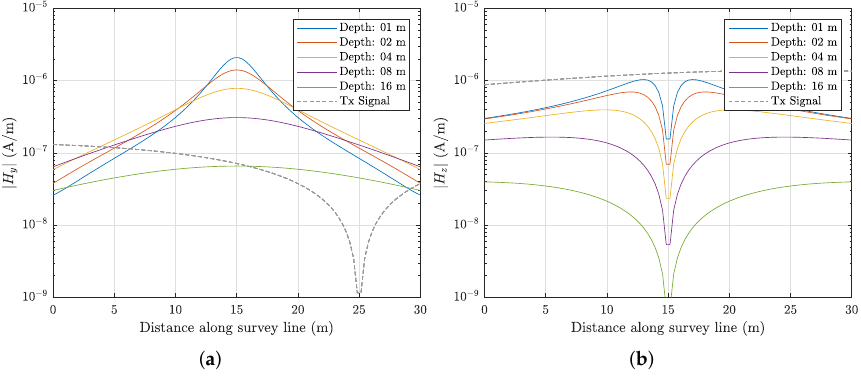
Figure 8. Model of a single receiver signal as a function of depth. ( a ) | H y | response. ( b ) | H z | response.